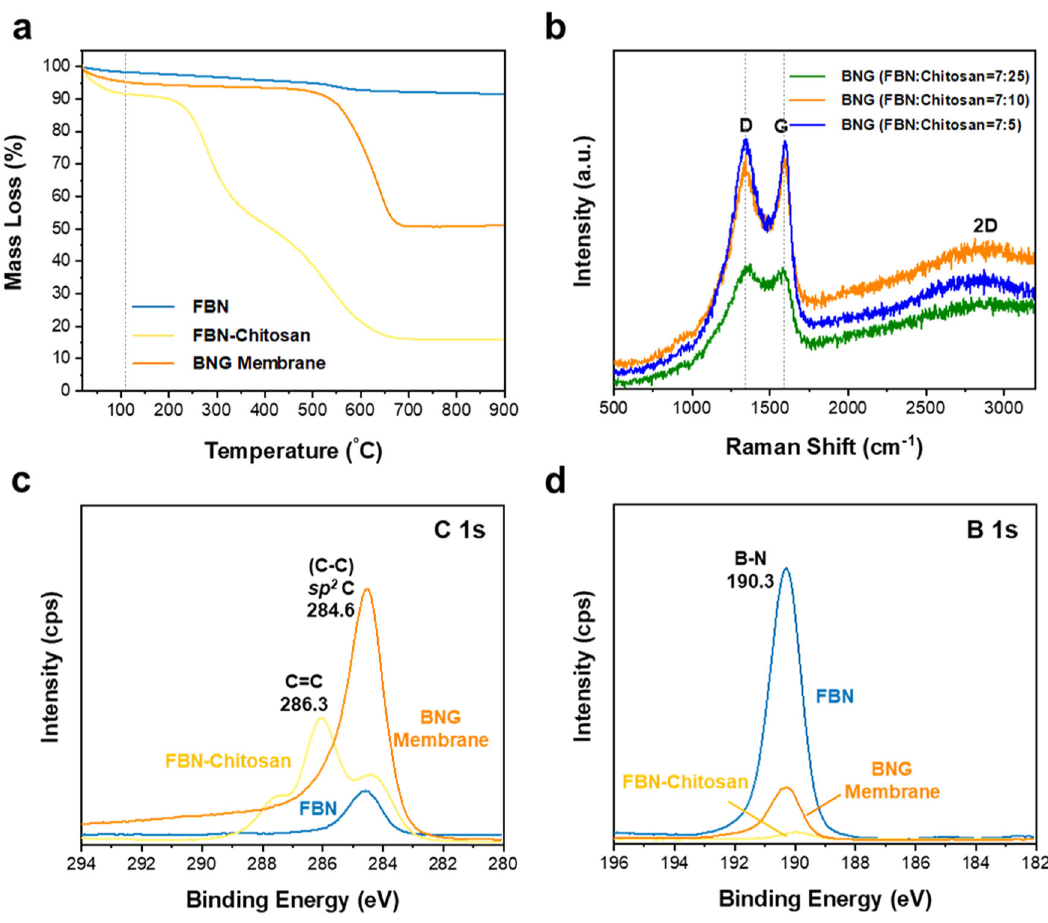
Fig. 2 | Chemical structure of FBN and chitosan fi lms, FBN-chitosan precursor and the prepared BNG heterostructured membranes. a Thermogravimetric analysis (TGA) of the FBN fi lm, FBN-chitosan precursor and BNG membranes (FBN:chitosan=7:10). b Raman spectra of BNG membranes with different